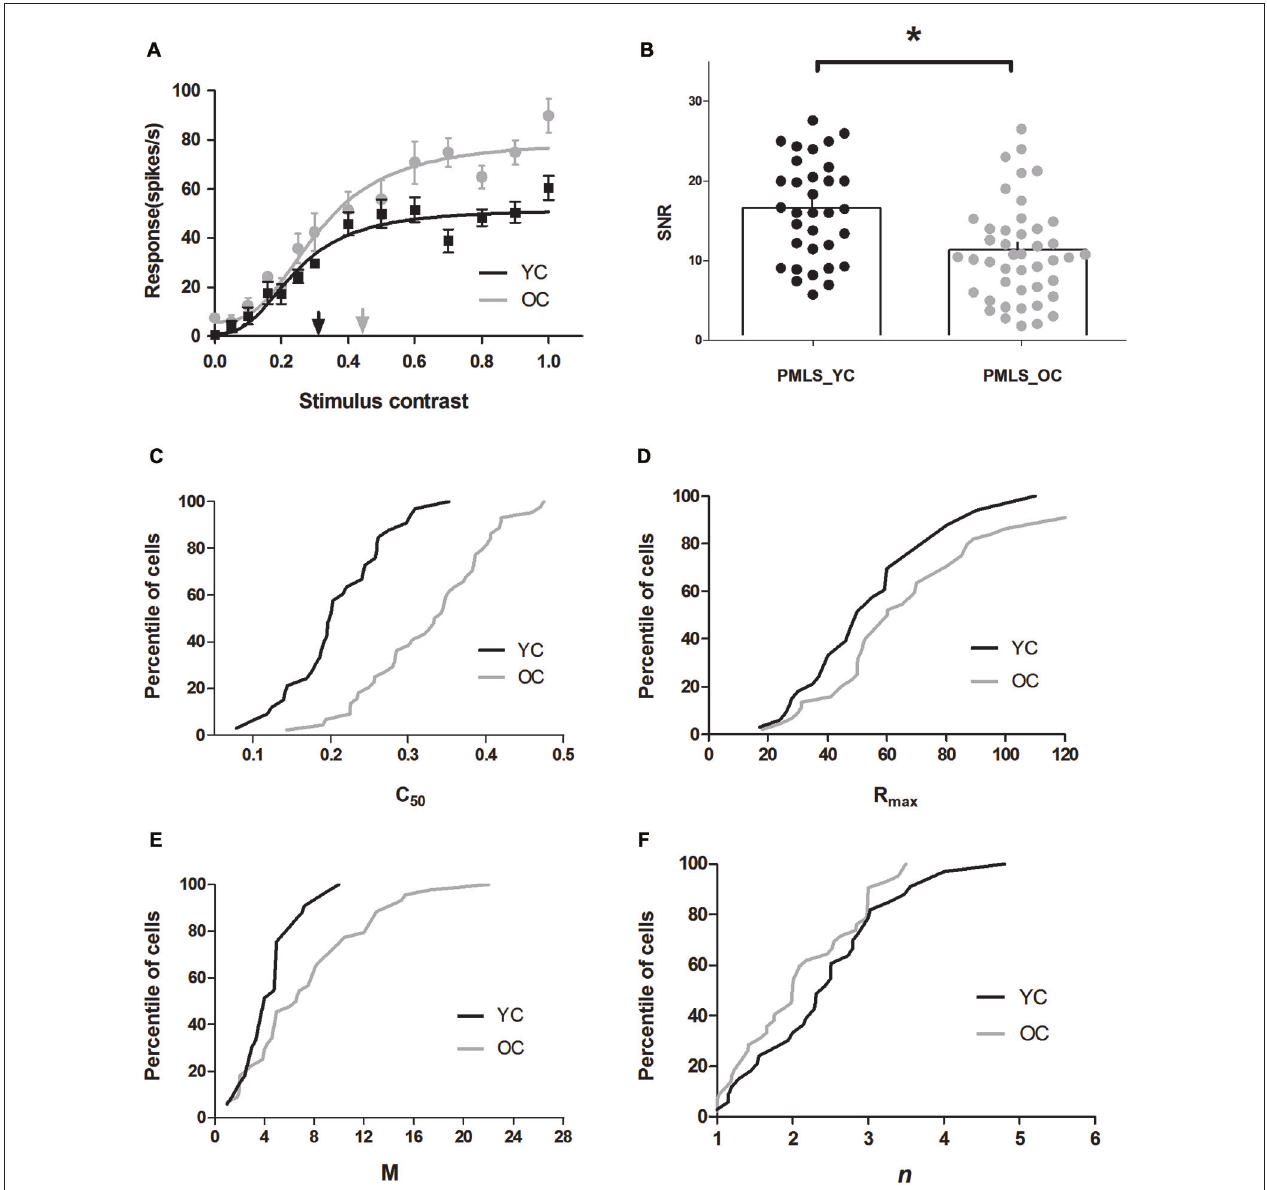
dots) cats, and mean values (histogram) of SNR values are illustrated. Percentile of PMLS neurons with given C 50 , R max , M , and n values are shown in panels C , D , E , and F , where black and gray lines represent the data of young and old cats, respectively. Error bars indicate SEM.